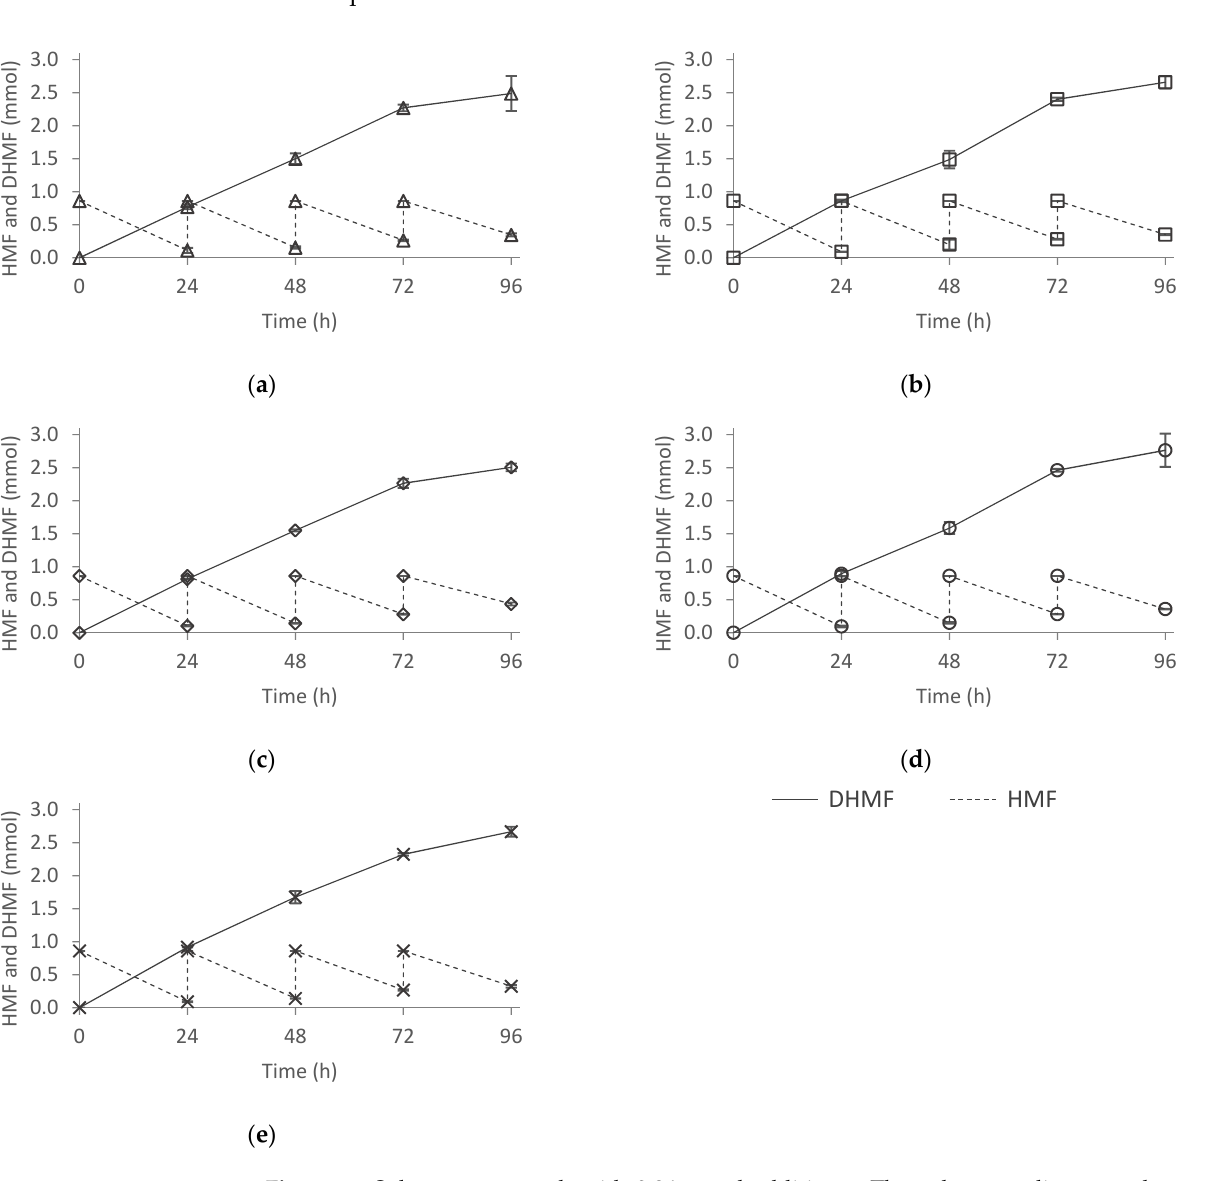
Figure 7. Substrate approach with 0.86 mmol additions. The culture media assayed were the following: ( a ) ME, ( b ) ME-50WP, ( c ) ME-50HA, ( d ) ME-50HN, and ( e ) ME50Meat. ME: malt extract medium; ME-50WP: malt extract medium without peptone and 50% of malt extract; ME-50HA: malt extract medium with 50% of malt extract replaced by Alcalase 2.4 L hydrolysate, ME-50HN: malt extract medium with 50% of malt extract replaced by Neutrase 0.8 L hydrolysate, and ME-50Meat: malt extract medium containing meat peptone.